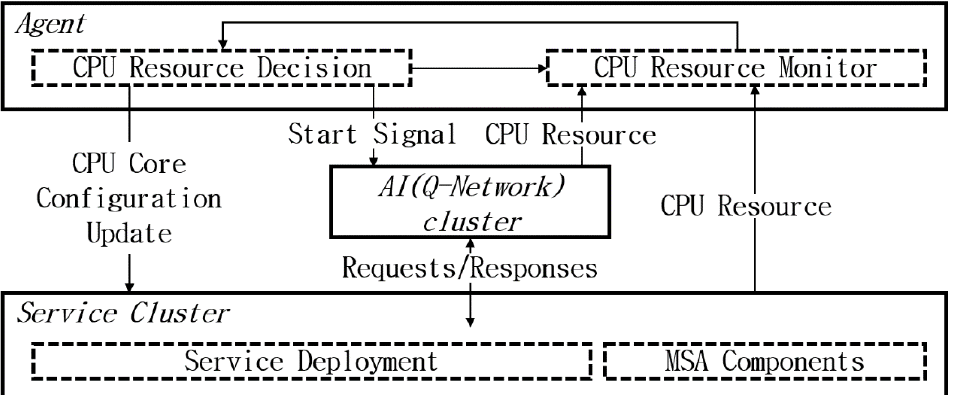
Figure 2. Proposed Intelligence Microservice Architecture for Auto-Scaling Performance Evalua- tion.